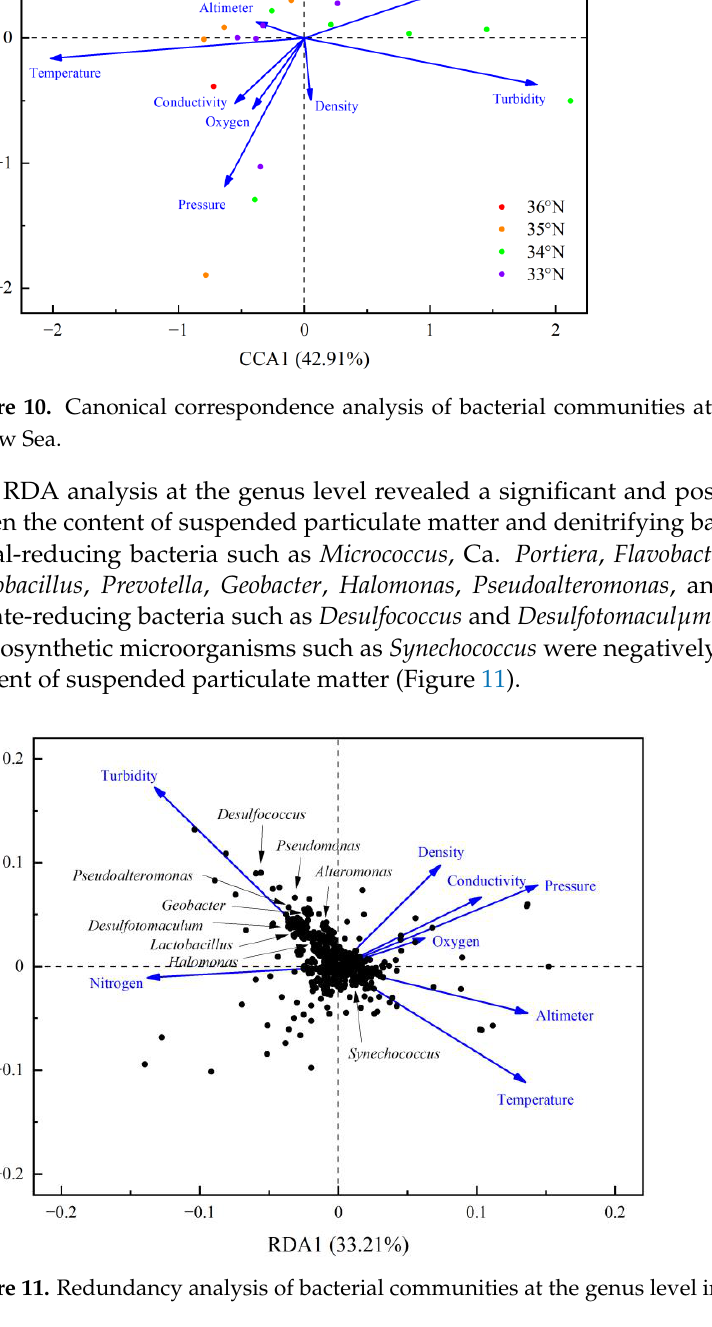
Figure 9. Principal component analysis plot of bacterial communities in Hangzhou Bay, Pearl River Estuary, Yangtze Estuary, and Yellow Sea.